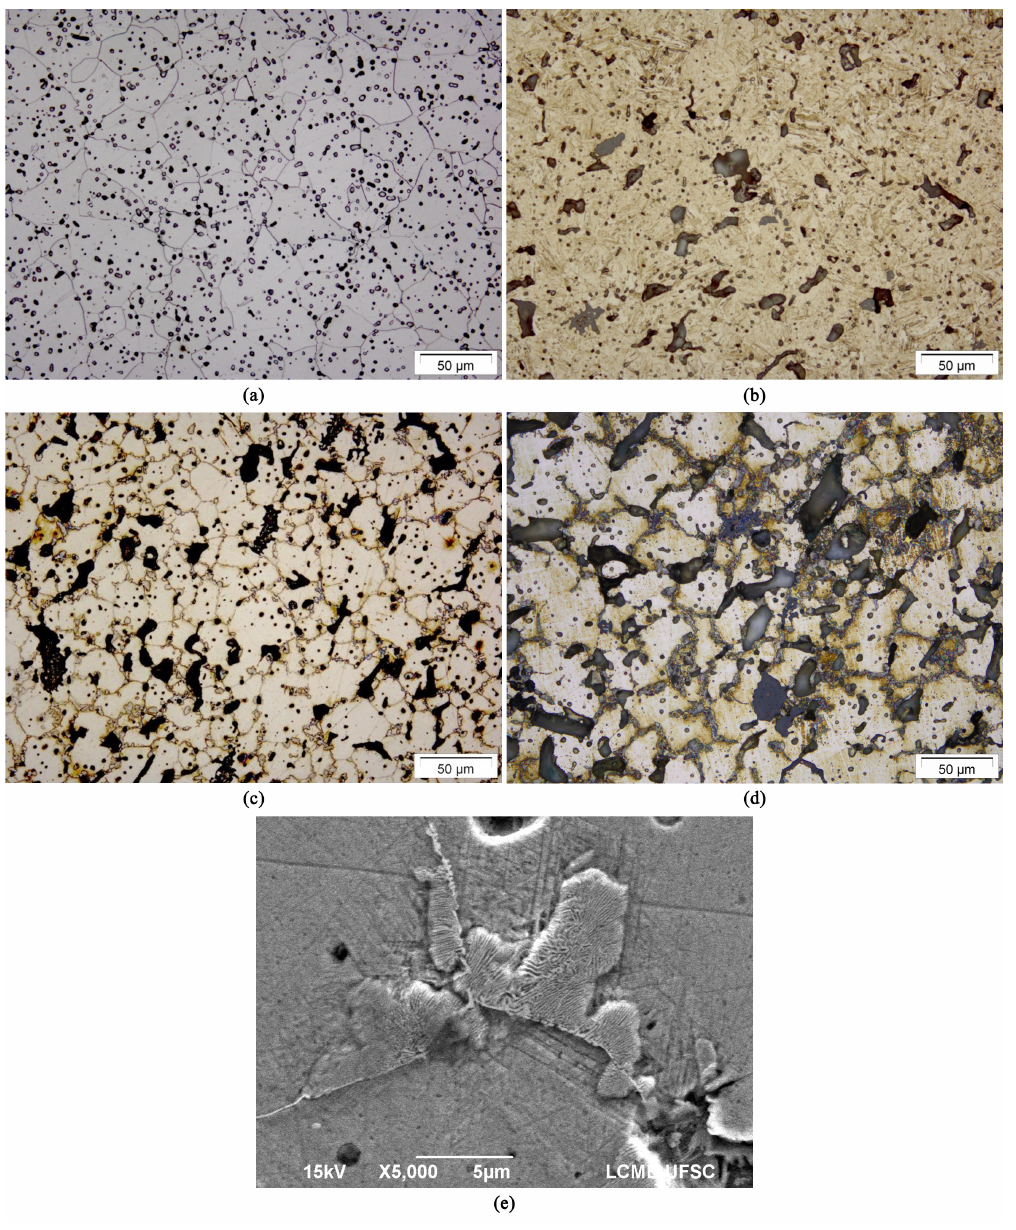
Figure 2. Microsctructural chracterization (specimen core areas) of the four materials presented in Table 1. (a) Fe. (b) Fe-12Mn. (c) Fe-12Mn-1C. (d) Fe-12Mn-1C-1Si. (e) SEM image of the precipitate formed in the Fe-Mn-C system. Author: Renan